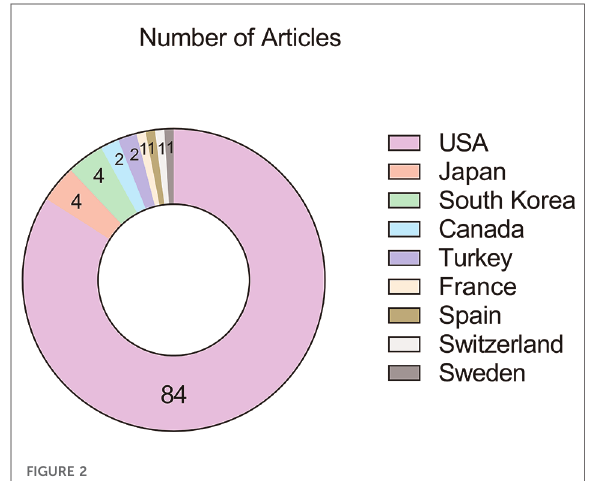
FIGURE 2 The countries of origin for the 100 most-cited articles on ASD.